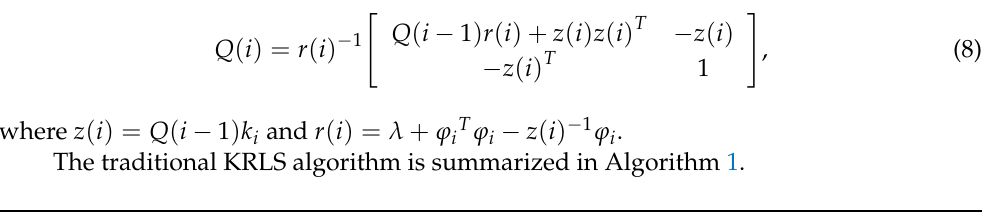
Algorithm 1 Traditional KRLS